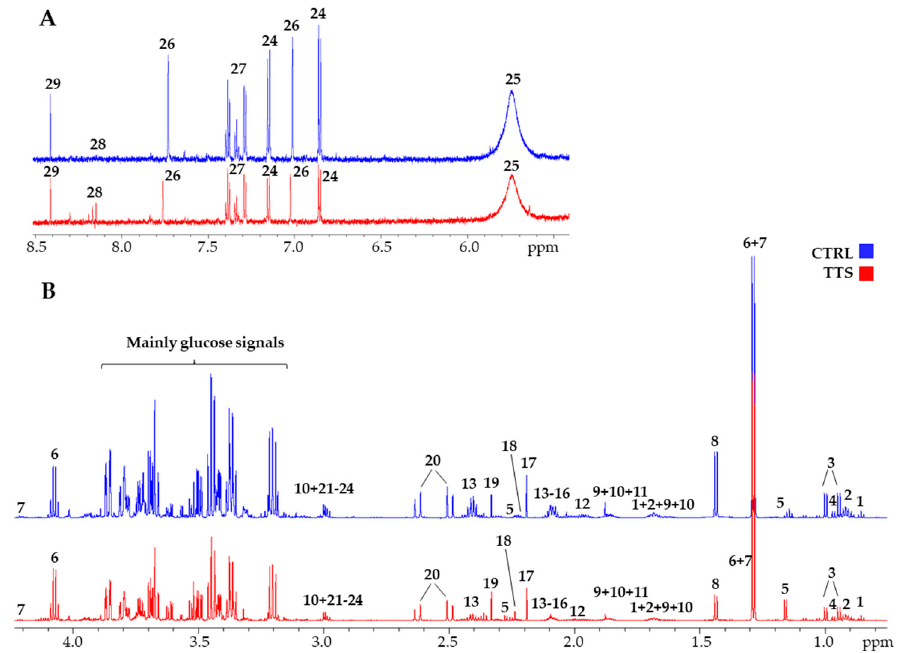
Figure 1. 700 MHz 1 H-NMR spectra of a TTS patient (red line) and a control (blue line). ( A ): aromatic portion; ( B ): aliphatic portion. The scale is set to the same internal standard concentration. 1: